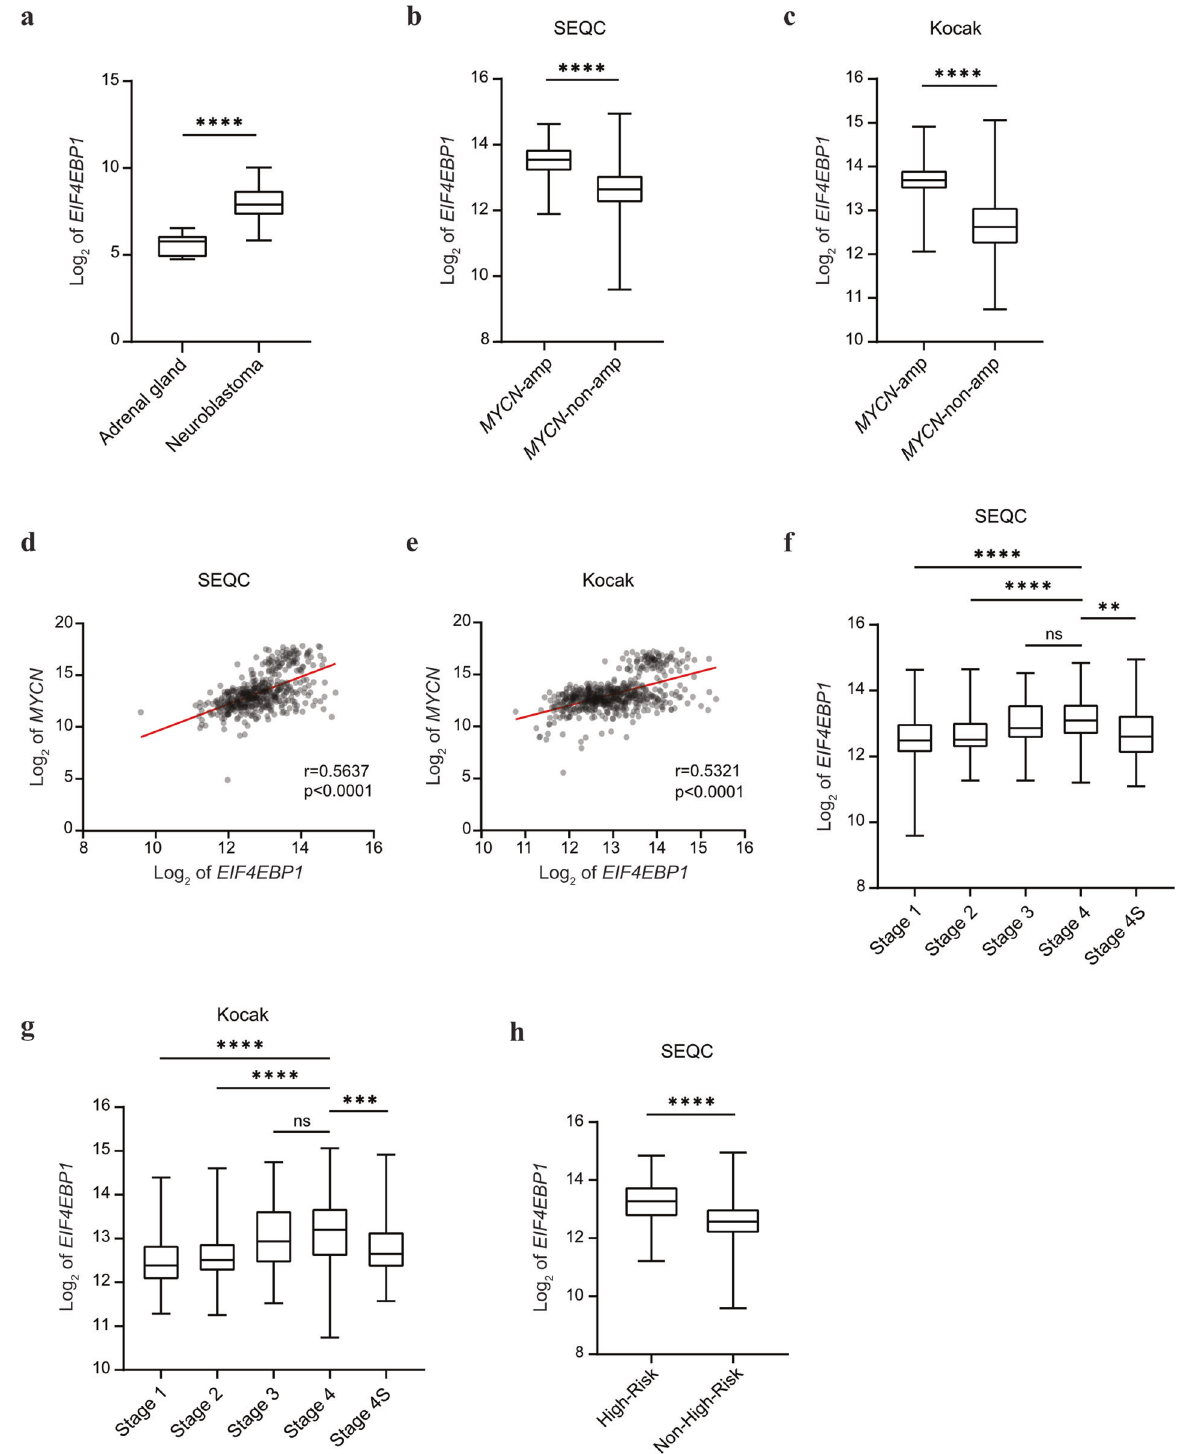
Fig. 1 EIF4EBP1 mRNA expression is associated with MYCN mRNA expression and is increased in more advanced and aggressive NB subsets. a Expression levels of EIF4EBP1 mRNA in a pool of four different NB cohorts (total n = 203), compared to healthy control tissues (adrenal gland, n = 13). b , c Expression levels of EIF4EBP1 mRNA in MYCN -ampli fi ed ( n = 92, SEQC [ b ] and n = 93, Kocak [ c ]) compared to MYCN - non-ampli fi ed ( n = 401, SEQC [ b ] and n = 550, Kocak [ c ]) NB patients of the SEQC ( b ) and Kocak ( c ) cohorts. d , e Expression levels of EIF4EBP1 mRNA plotted against expression levels of MYCN mRNA in SEQC ( r = 0.5637, d ) and Kocak ( r = 0.5321, e) cohorts. f , g Expression levels of EIF4EBP1 mRNA per NB stage in SEQC ( f ) and Kocak ( g ) cohorts. h Expression levels of EIF4EBP1 mRNA in high-risk ( n = 176) compared to non- high-risk ( n = 322) NB in the SEQC cohort. Data were retrieved from the R2: Genomics Analysis and Visualization Platform. Statistics were determined using Mann – Whitney U -test. Exact p -values are presented. * P < 0.05, ** P < 0.01, *** P < 0.001, **** P < 0.0001.